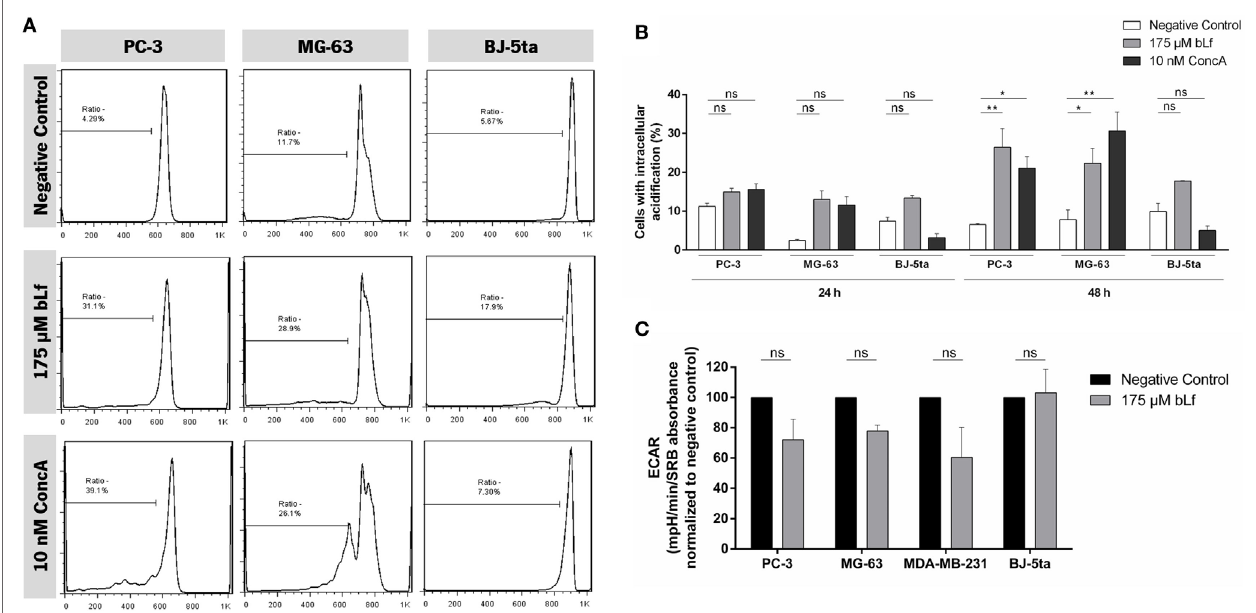
FigUre 4 | Effect of bovine lactoferrin (bLf) on the intracellular acidification and basal extracellular acidification rates (ECARs) in the highly metastatic cancer cell lines PC-3 and MG-63 and in the non-tumorigenic cell line BJ-5ta. (a) Representative histograms of the percentage of BCECF-AM-loaded cells displaying intracellular acidification assessed through the decrease of FL1/FL4 median fluorescence intensity ratio in comparison to negative control cells at 48 h. (B) Quantification of the percentage of cells displaying intracellular acidification after treatment with 175 µM bLf or 10 nM concanamycin A (ConcA), for 24 and 48 h (identified under the cursor on ratio). Values represent the mean ± SD of three independent experiments; ns, non-significant, * P < 0.05 and ** P < 0.01 compared with the negative control of each cell line. (c) Basal ECARs of cells after 24 h incubation in the absence (negative control) or presence of 175 µM bLf. The bLf sensitive highly metastatic breast cancer cell line was used for comparison. ECAR values are normalized to the negative control cells of each cell line. Results are expressed in mpH per minute per sulforhodamine B (SRB) absorbance at 540 nm. Values represent the mean ± SD of three independent